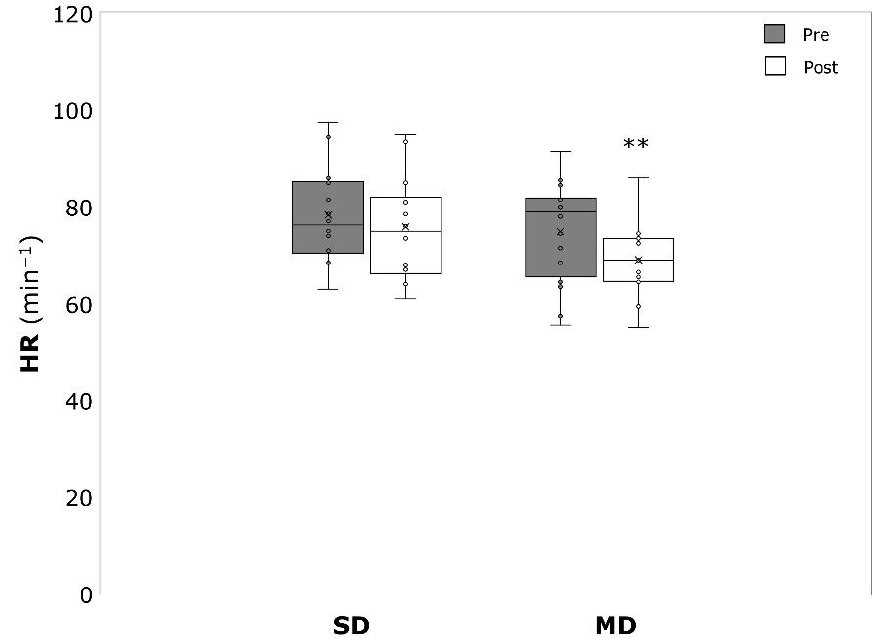
Figure 7. Heart rate (HR) before (pre) and after (post) the intervention period for severely depressed (SD) and mildly depressed (MD). ** p < 0.01 within-group difference.